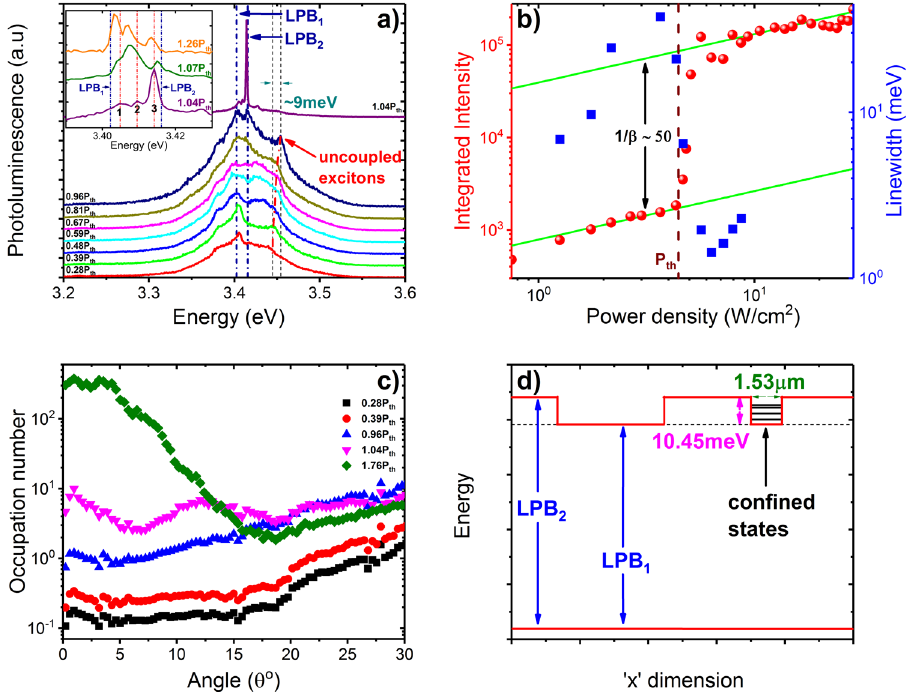
Figure 4. Polariton laser characteristics and sample schematic in line with observations. ( a ) PL spectra obtained from membrane 5 at 300 K using the k-space setup in spectroscopy mode, for power densities between 0.28 · P th and 1.04 · P th . Inset: PL spectra above threshold, for power densities between 1.04 · P th and 1.26 · P th , revealing three emission lines in the energy range between the LPB 1 and LPB 2 . ( b ) Integrated PL intensity (red circles) in the region around the LPB 1 and LPB 2 , and linewidth (blue squares) of the LPB 1 peak (below threshold) and of level ‘1’ peak (above threshold), as a function of pump power density. ( c ) Occupation number as a function of pump power density, from 0.28 · P th to 1.76 · P th . ( d ) An energy schematic of membrane 5, depicting the two regions corresponding to LPB 1 and LPB 2 , and highlighting the square-like pocket